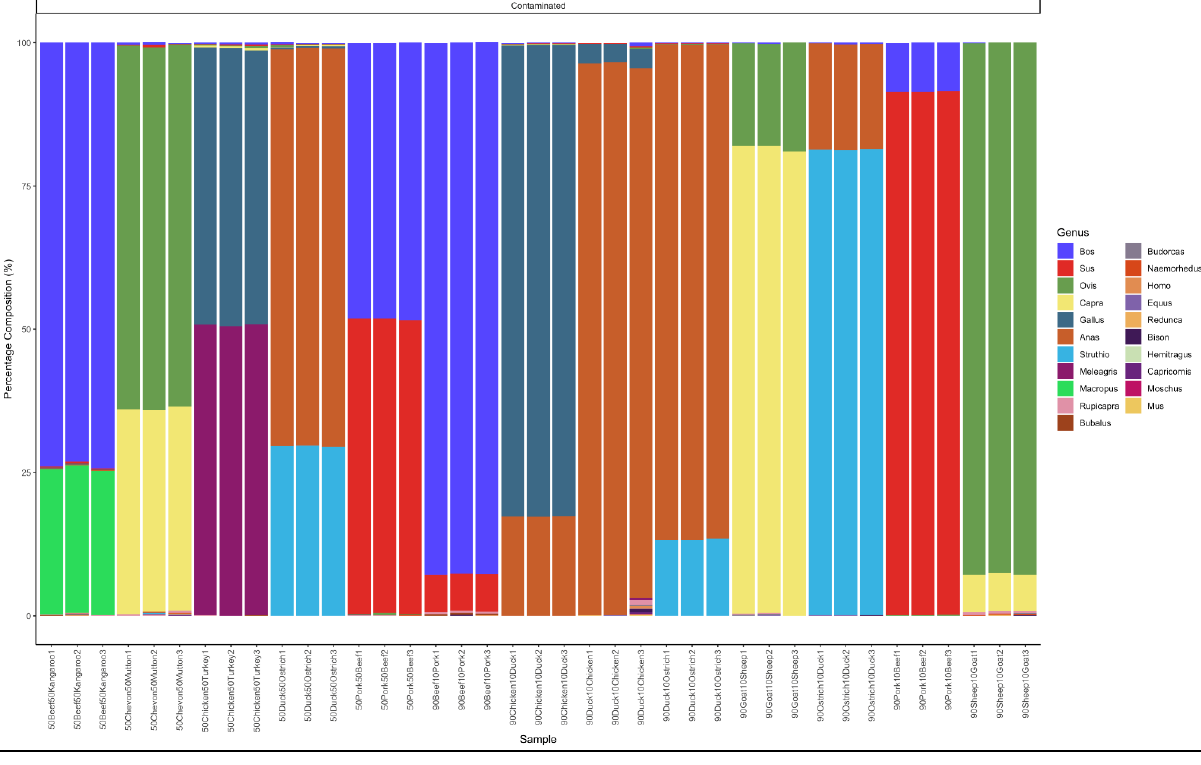
Figure 3. Percentage of average fold of pure DNA from two known meat types artificially mixed at a ratio of 1:1